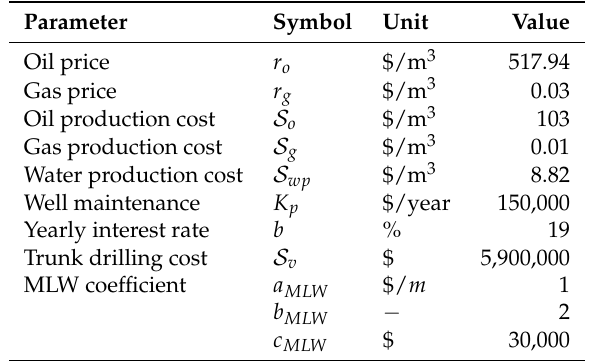
Table 2. Economic assumptions for the optimization framework. MLW, multilateral well.